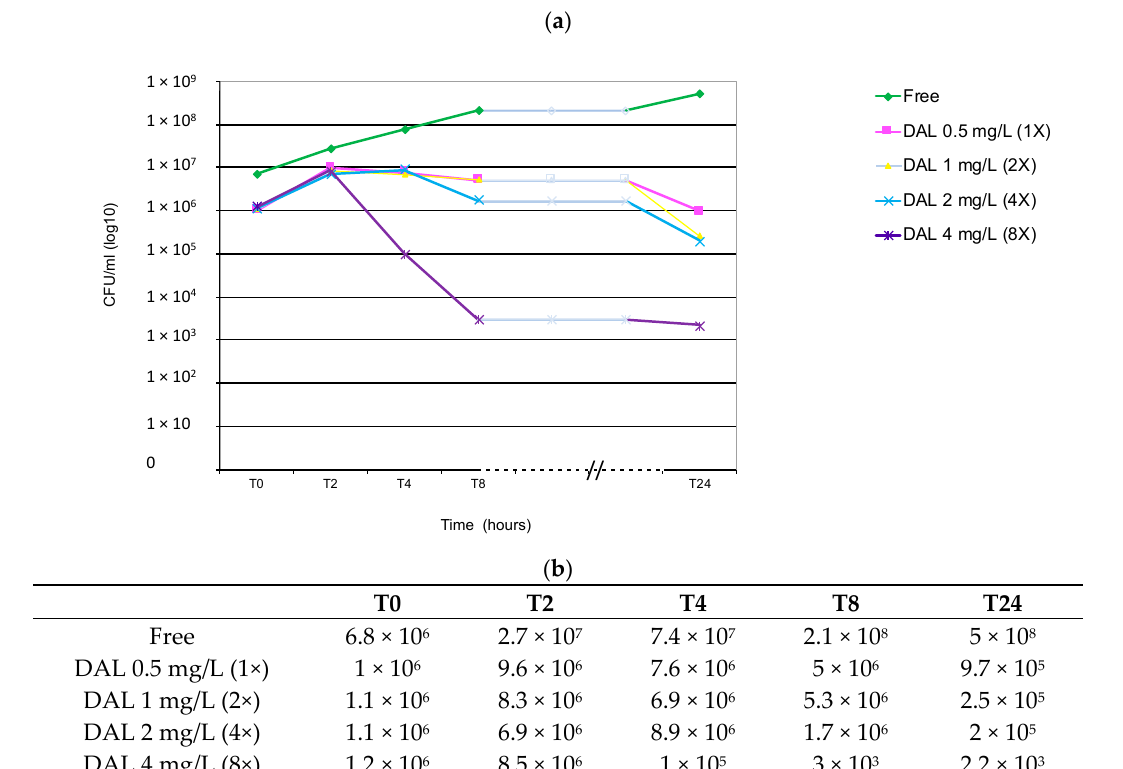
Figure 2. MRSA RIF-R ST228-I-t041 MIC (1X) 0.5 mg/L. ( a ) Graph of curves obtained. ( b ) Average of duplicate viable counts (CFU / mL) observed at T0-T2-T4-T8 and T24 time intervals and after exposure to di ff erent concentration of dalbavancin (1-2-4 and 8X MIC). DAL: dalbavancin. Time (hour): 0, 2, 4, 8 and 24 h after the starting inoculum. The red row represents the threshold of bactericidal activity ( ≥ 3 log 10